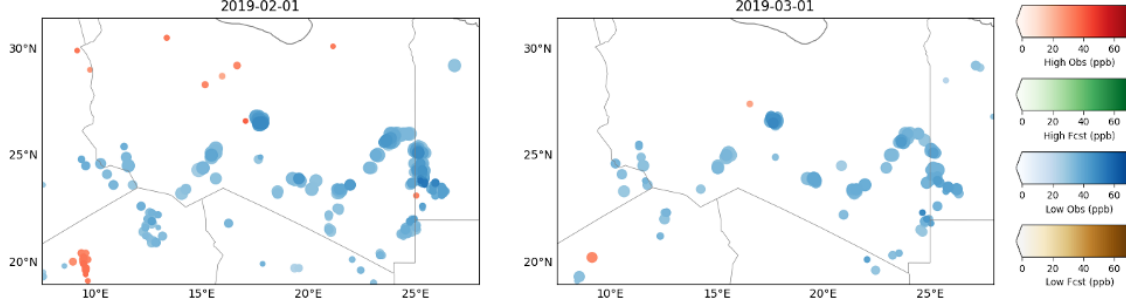
Figure 13. Outlier detection and classification over Libya, Egypt and Niger. Dates indicate the end date of the 30d time